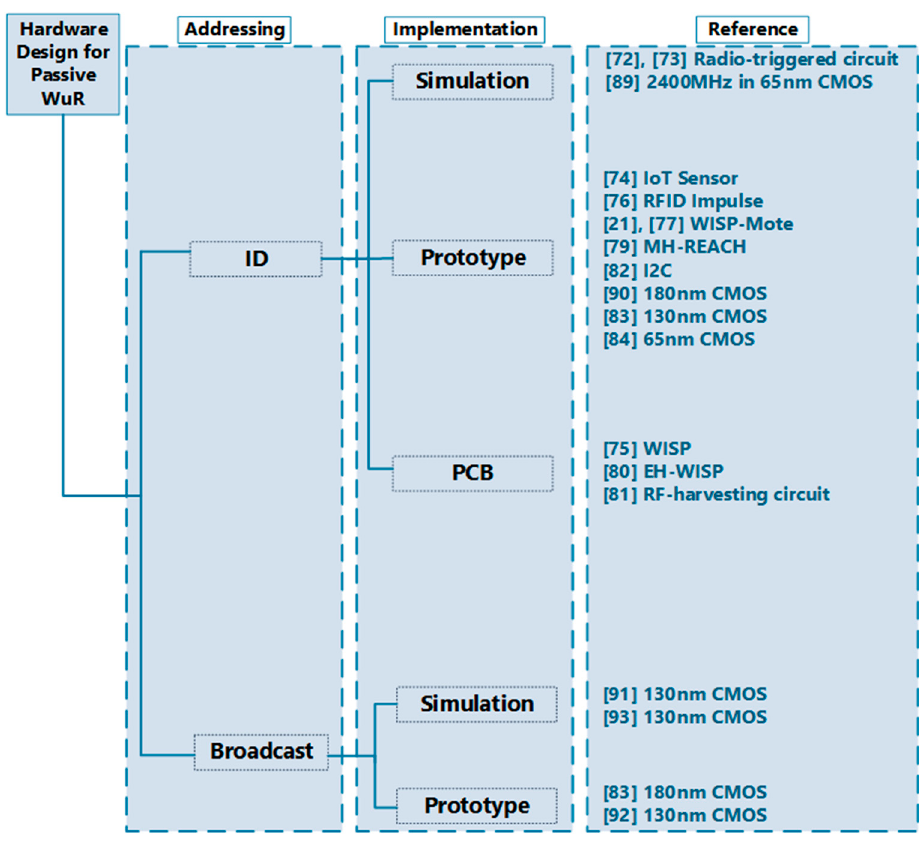
Figure 3. Classification of the previous works on passive wake-up radio hardware design.